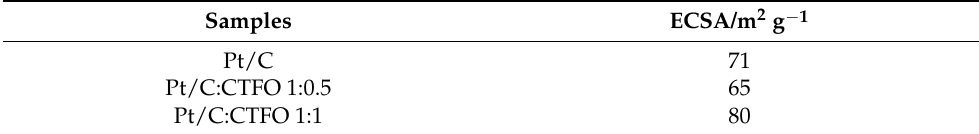
Table 2. Electrochemically active surface area (ECSA) values for the various catalyst compositions. Samples